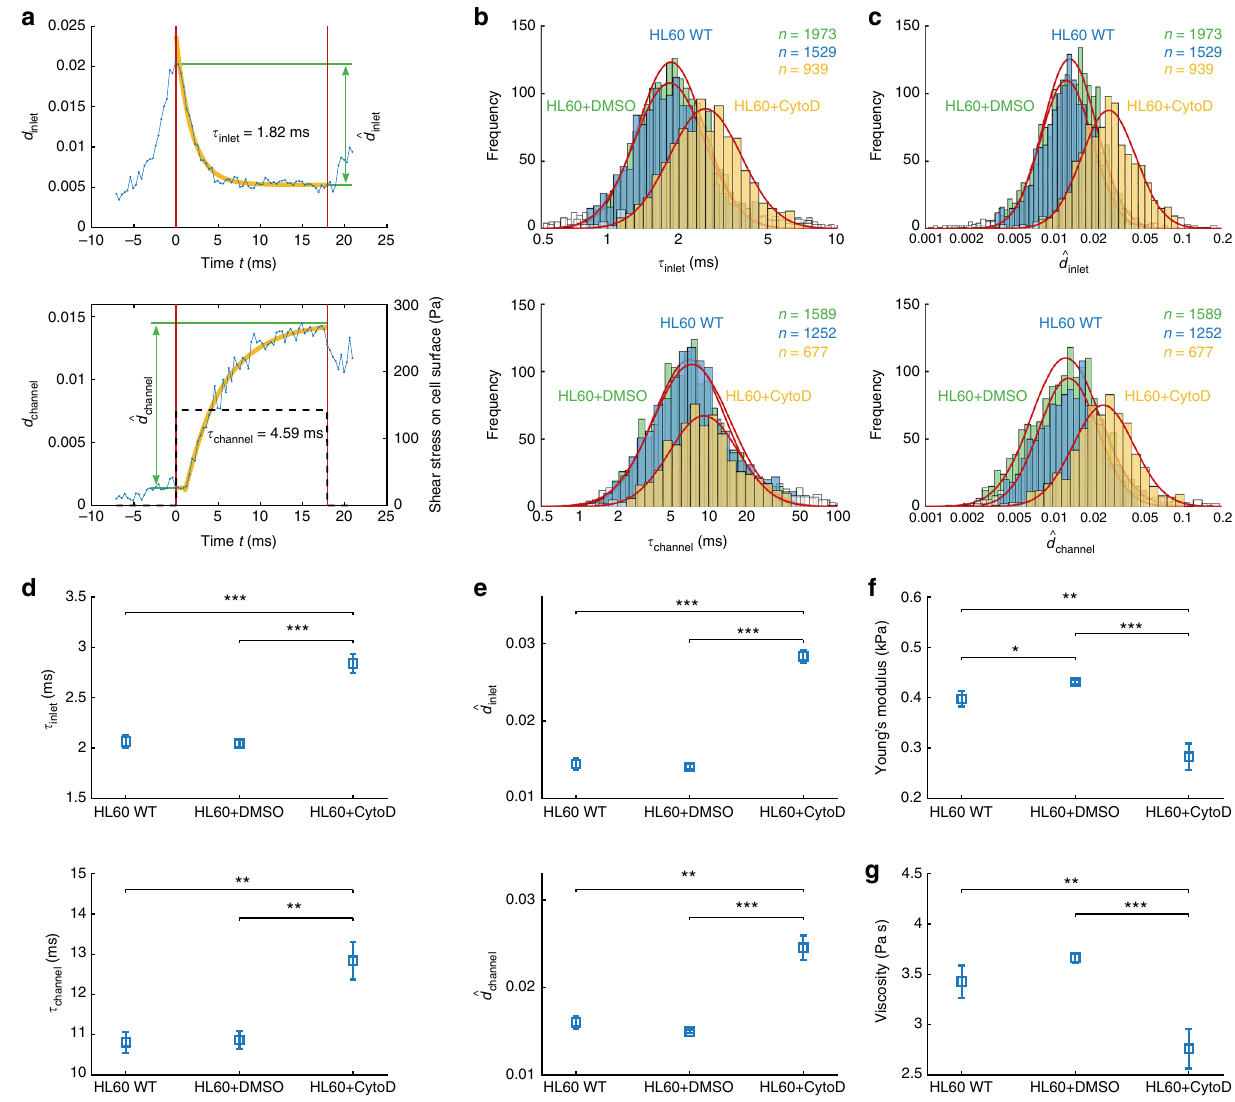
Fig. 3 Single-cell rheology on HL60 cells. a Reconstructed deformation trace d inlet (top) and d channel (bottom) from fi rst four even (top) and fi rst fi ve odd (bottom) cell shape modes including a 0 , respectively (blue). Graphs show relaxation times τ inlet and τ channel (yellow) as well as peak deformations ^ d inlet and ^ d channel (green). Dashed line (bottom) represents mean shear stress on cell surface. The red vertical lines indicate channel inlet and outlet position. b Histograms of characteristic times τ inlet and τ channel are binned logarithmically and show wild-type cells (blue), cells after treatment with 1 μ M CytoD (yellow) and the corresponding DMSO control (0.25% (v/v), green). c Histograms of peak deformation ^ d inlet and ^ d channel are binned logarithmically and show wild-type cells (blue), cells after treatment with 1 μ M CytoD (yellow) and the corresponding DMSO control (green). In b and c data in a con fi dence interval of 3 σ have been taken into account for the log-normal fi t (red line), others are considered as outliers (white bins). d – g Statistical analysis for three biological replicates comparing wild-type cells ( n = 3382), cells after treatment with 1 μ M CytoD ( n = 2643) and corresponding DMSO control ( n = 3965) for characteristic timescales τ inlet and τ channel d , for peak deformation ^ d inlet and ^ d channel e , for Young ’ s modulus E f and viscosity η g . Measurements have been carried out in a 30 × 30 µ m channel at a fl ow rate of 8 nl s − 1 . The mean shear rate of 5100 s − 1 and the mean shear stress of 142 Pa on the cell surface has been derived from fi nite element method simulations considering the full micro fl uidic geometry. Statistical signi fi cance has been calculated from linear mixed models and error bars represent standard error of the mean (* p < 0.05; ** p < 0.01; *** p <